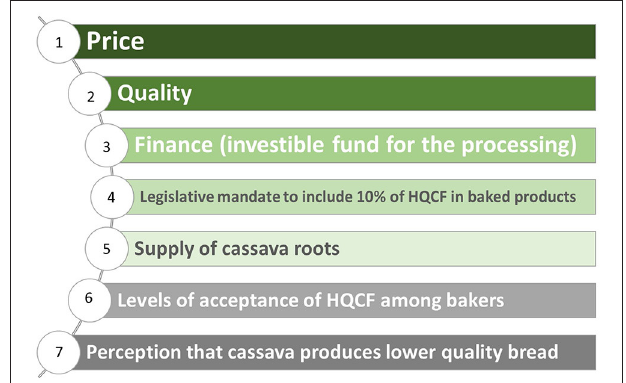
FIGURE 8 | Factors influencing the production of high-quality cassava flour (HQCF). Factors are ranked on a scale of 7, where 1 is the highest and 7 is the